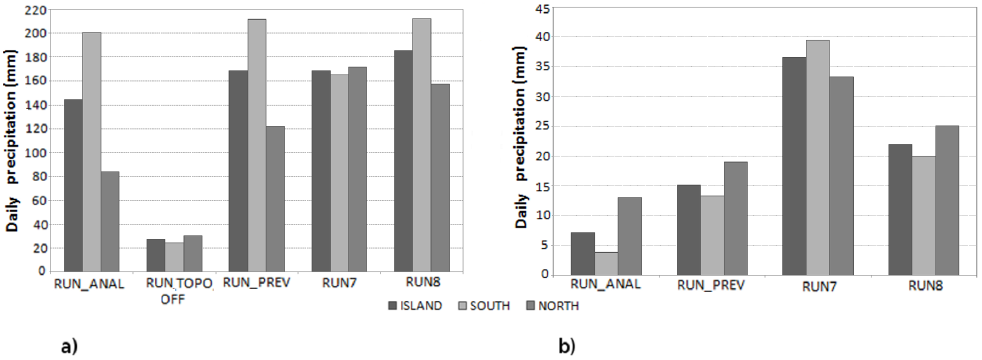
Fig. 5. (a) Daily precipitation, averaged over the whole Madeira Island and its southern and northern coasts, for domain D2, and (b) daily precipitation averaged for locations at altitudes lower than 800m, for domain D2. Fig. 5. a ) Daily precipitation, averaged over the whole Madeira Island, and its Southern and Northern coasts, for domain D2, and b ) Daily precipitation averaged for locations at altitude lower than 800m, for domain D2.